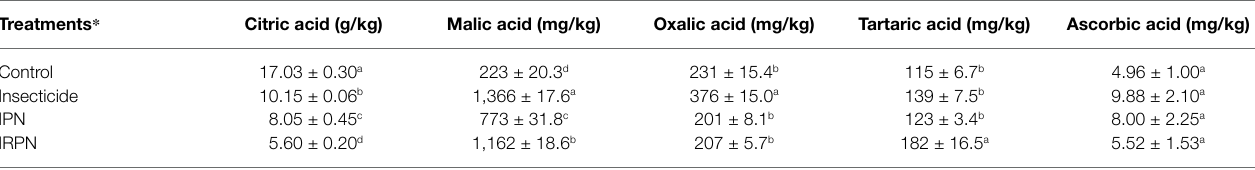
TABLE 1 | Concentration of organic acids in Chinese bayberry in different planting environments.